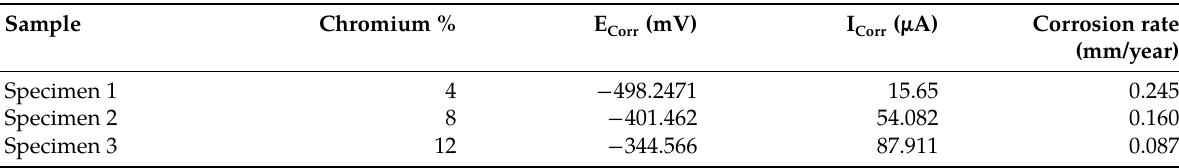
Table 5: Corrosion